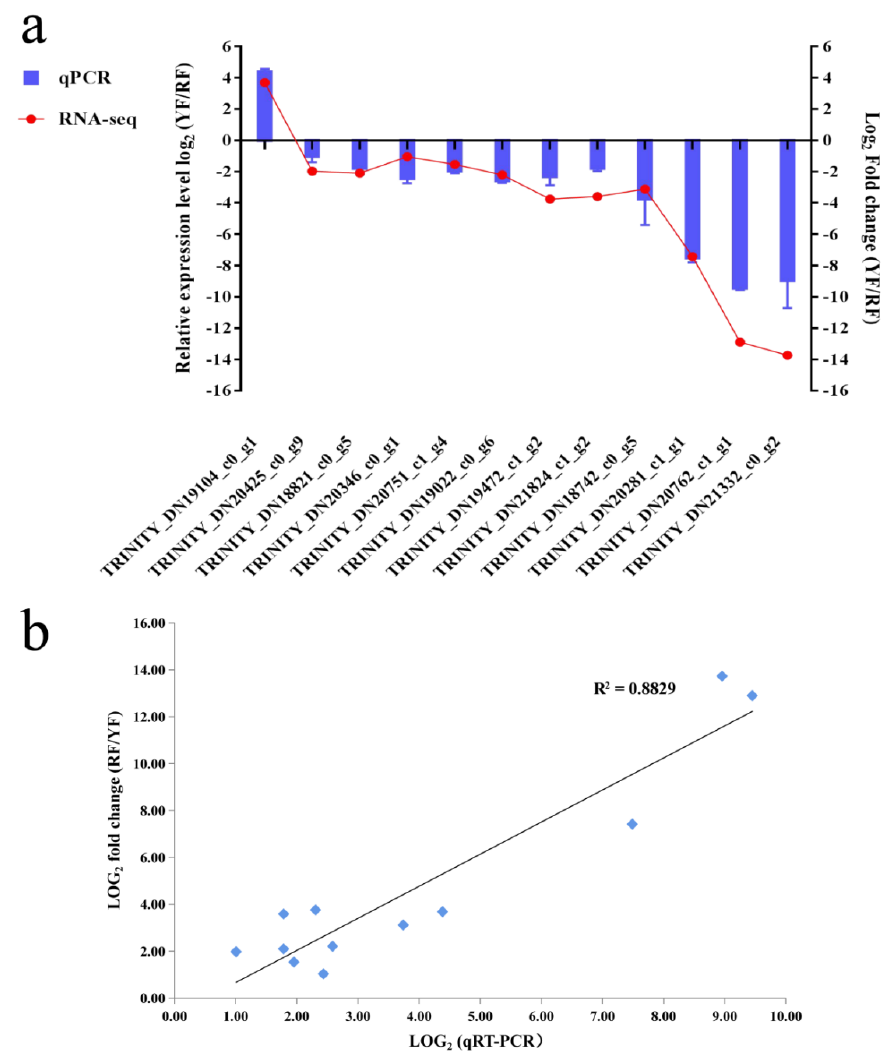
Figure 7. Quantitative real-time PCR (qRT-PCR) validation of 12 DEGs. ( a ) Expression patterns of 12 genes involved in anthocyanin biosynthesis. Each column represents an average of three biological replicates, with standard errors indicated by vertical bars. ( b ) Correlation of the expression levels of 12 selected genes measured by qRT-PCR and RNA-seq. RF: red fruit; YF: yellow fruit.